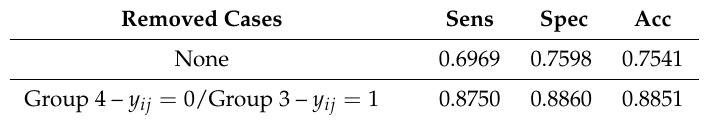
Table 11. Sens, Spec and Acc measures under data-influence analytics for the asthma data.